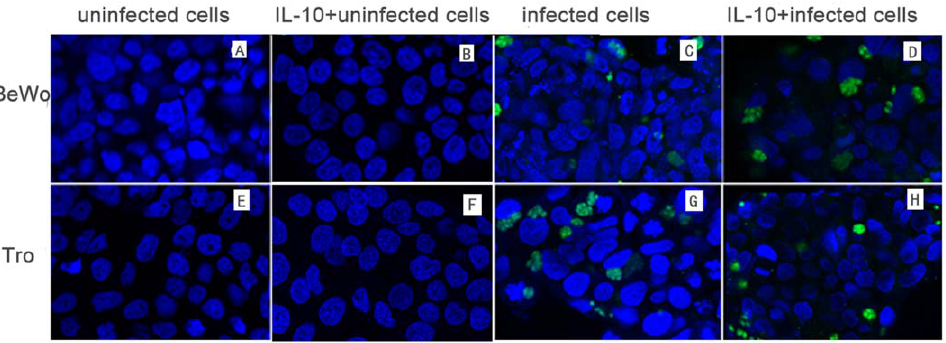
Figure 4. Hoechst 33258 staining of BeWo cells and trophoblasts at 24 hr after challenge with T.gondii . (A) Uninfected BeWo cells, (E) uninfected trophoblasts, (B) uninfected BeWo cells treated with IL-10, (F) uninfected trophoblasts treated with IL-10, (C) infected BeWo cells, (G) infected trophoblasts, (D) infected BeWo cells treated with IL-10, and (H) infected trophoblasts treated with IL-10 were fixed, stained with Hoechst 33258, and observed by microscopy. Apoptosis was indicated by nuclei fragmentation or crescent shaped nuclei. Most of apoptotic nuclei were at a distance from the parasitophorous vacuoles (PV) and nuclei close to parasitophorous vacuoles usually showed normal appearances. The results also showed that the apoptotic cells increased in infected cells compared to uninfected cells and decreased with IL-10 treatment while there was no significantly difference between IL-10 treated uninfected cell and uninfected cells.